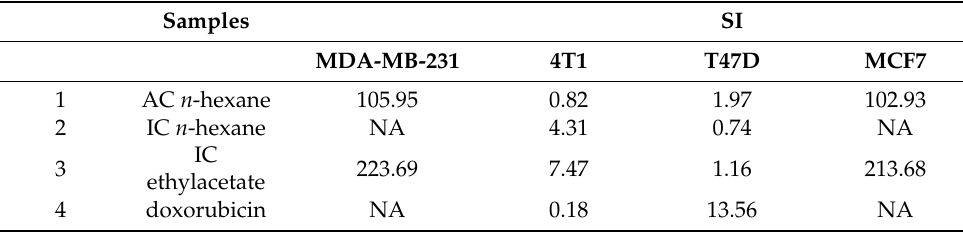
Table 2. The safety index (SI) of the three partitions is calculated from the ratio between the IC 50 of the samples in the cancer cells over its IC 50 in the Vero cells.